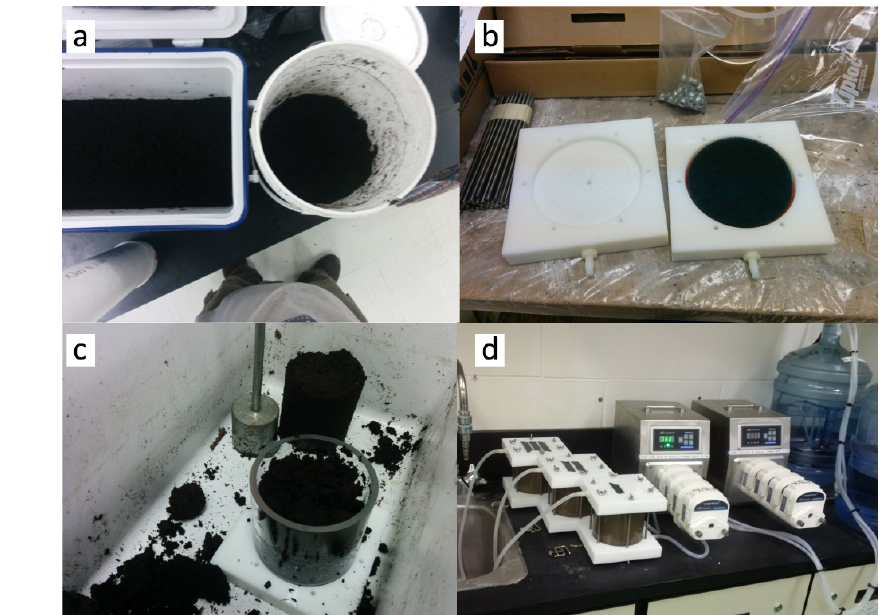
Figure A1. Pictures from saturated transport experiment: (a) cleaning and mixing the peat; (b) flowthrough cell plates (the green pad is below the sample, redistributing the water beneath it); (c) packing cell with peat; and (d) flowthrough experiment setup (cells are connected to a pump drawing the solution from a container on a magnetic stirrer).